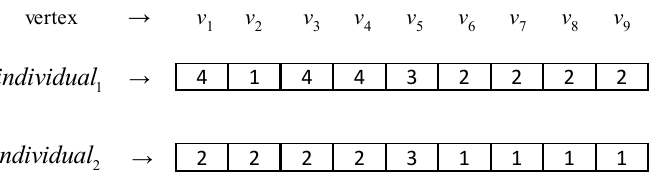
Figure 3. Two individuals with a random community IDs for each vertex.